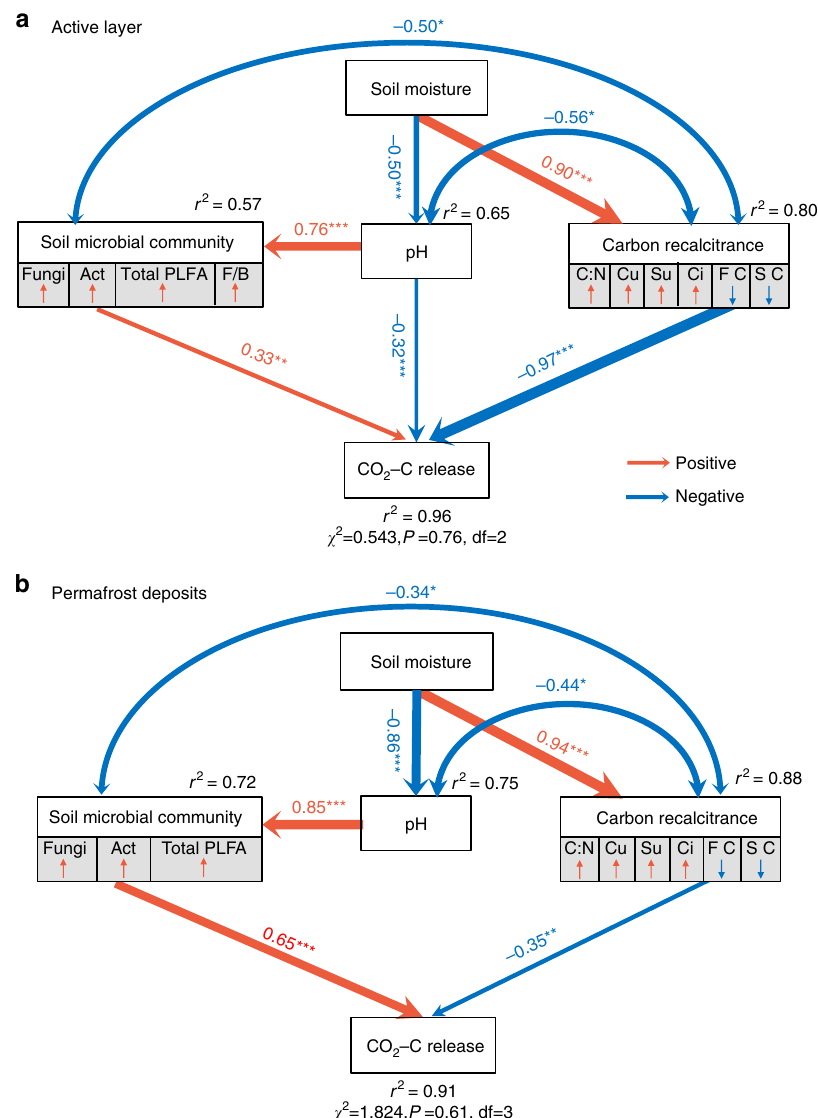
Figure 4 | Structure equation modelling (SEM) examining the multivariate effects on CO 2 –C release. Effects of soil moisture, pH, microbial community and C recalcitrance on CO 2 –C release as revealed from SEM for ( a ) active layer ( n ¼ 15) and ( b ) permafrost deposits ( n ¼ 15). Double-headed arrows represent covariance between related variables. Single-headed arrows indicate the hypothesized direction of causation. Red and blue arrows indicate positive and negative relationships, respectively. Arrow width is proportional to the strength of the relationship. Double-layer rectangles represent the first component from the PCA conducted for soil microbial community and C recalcitrance. Soil microbial community includes total PLFAs, fungal PLFAs (Fungi), actinomycic PLFAs (Act) and fungi/bacteria (F/B) as indicated by PLFA analysis; C recalcitrance includes C:N, cutin-derived components (Cu), suberin- derived components (Su), lignin cinnamyl units (Ci), fast C pool size (FC) and slow C pool size (SC). The soil moisture data used in the SEM were the moisture in the field rather than that during incubation. The red symbol ‘ m ’ and blue symbol ‘ k ’ indicate a positive or negative relationship between the variables and the first component from the PCA, respectively. The numbers adjacent to arrows are standardized path coefficients, which reflect the effect size of the relationship. The proportion of variance explained ( r 2 ) appears alongside each response variables in the model. Goodness-of-fit statistics for the model are shown below the model. * P o 0.05, ** P o 0.01, *** P o